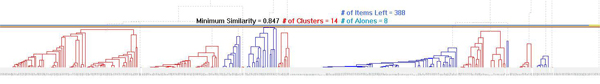
Functional clustering (molecular function) of Clus1 of Home sapiens. Table 4 provides the details on functional cohesiveness.